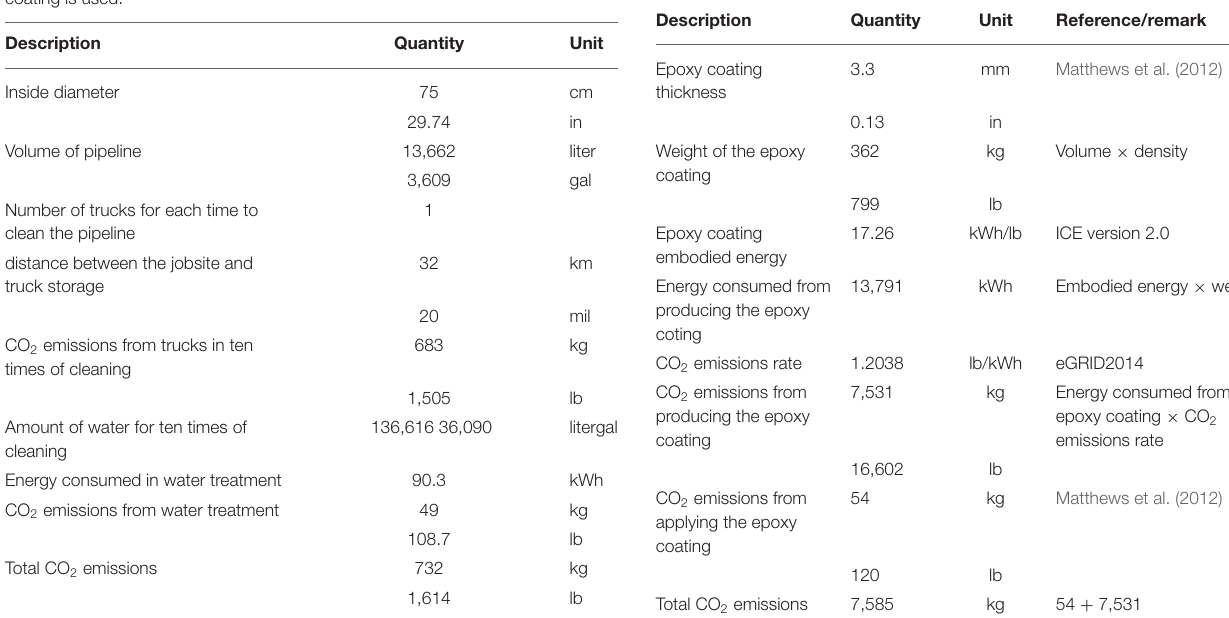
TABLE 7 | Total carbon emissions of the epoxy coating.